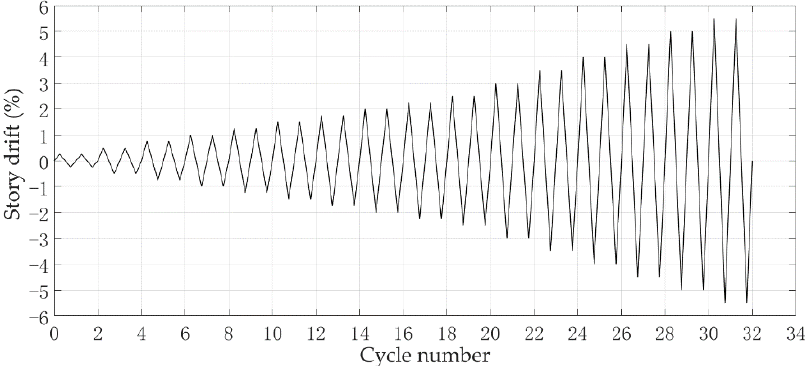
Figure 5. Lateral loading protocol.